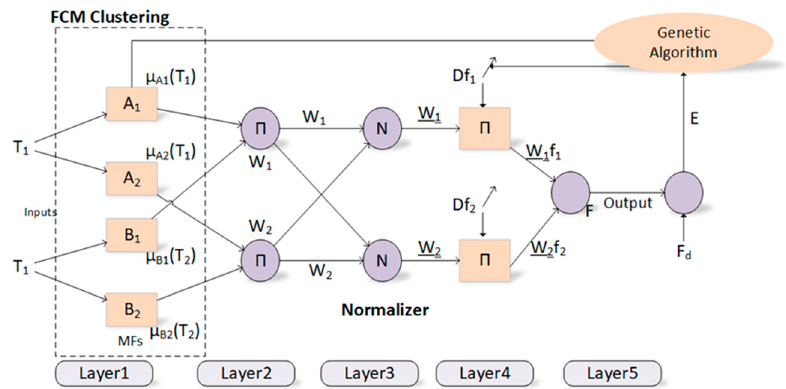
Figure 3. Block diagram for the proposed method .